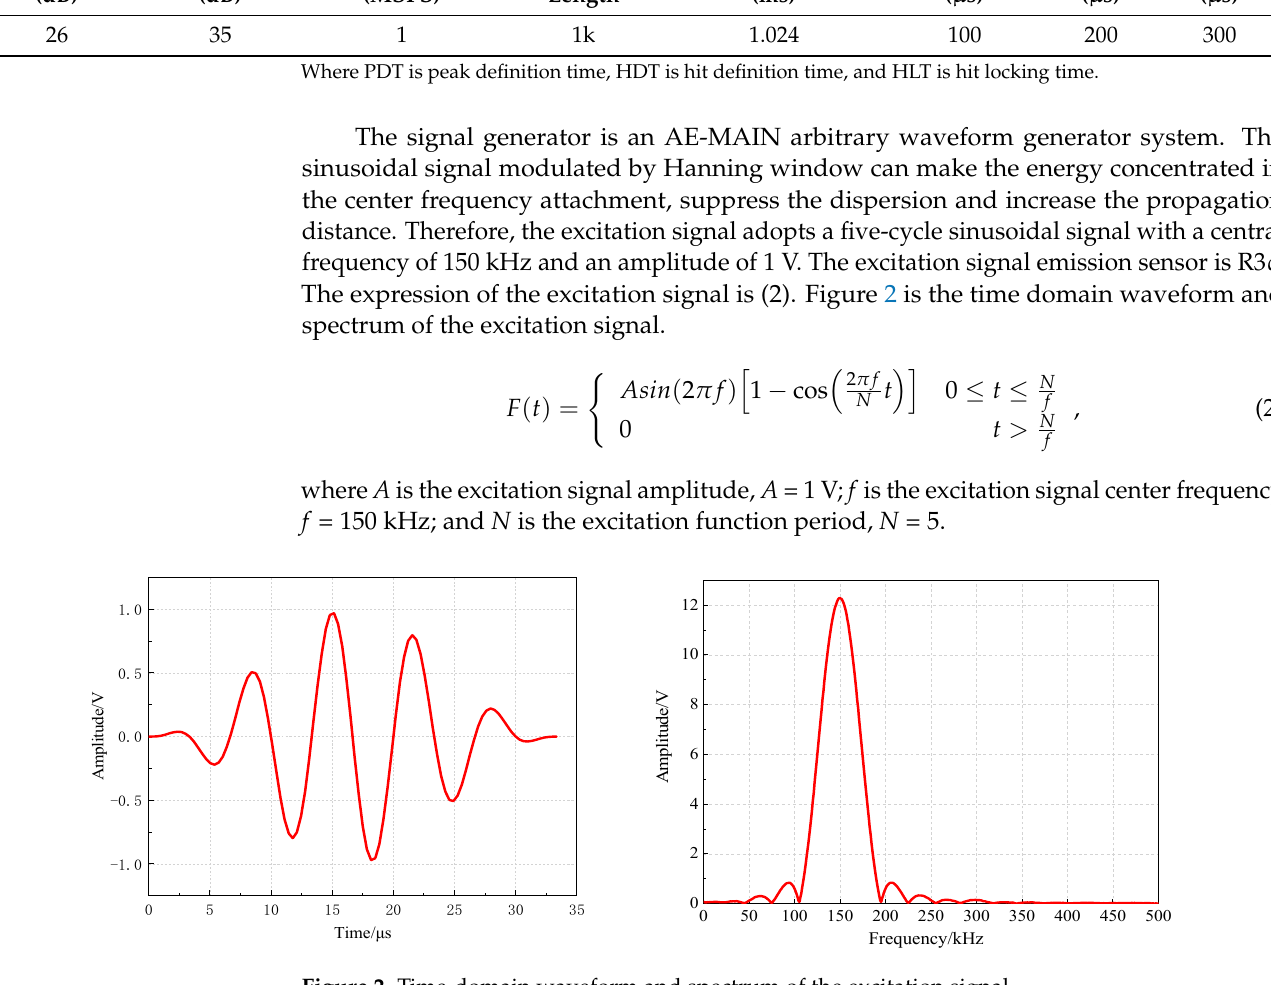
Figure 2. Time − domain waveform and spectrum of the excitation signal. Figure 2. Time-domain waveform and spectrum of the excitation